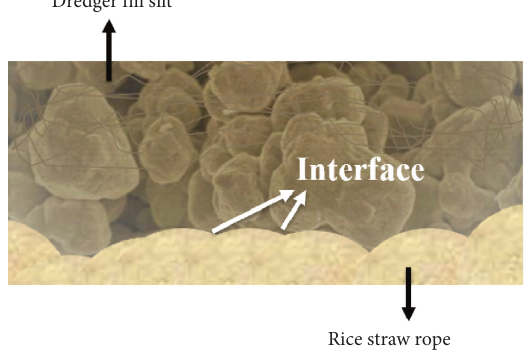
Figure 9: Interface